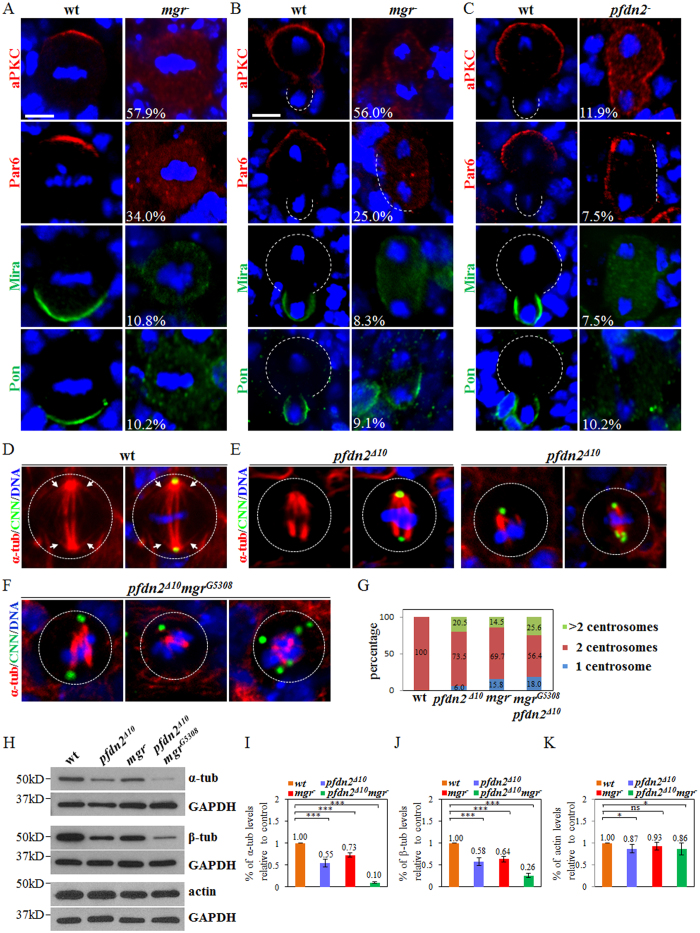
Pfdn2 and Mgr regulate neuroblast asymmetric division and mitotic spindle assembly.(A,B) Larval brains of wild-type and mgr− [mgrG5308/Df(3R)Exel6160] hemizygote larvae were labeled with aPKC, Par6, Mira, Pon and DNA. (C) aPKC, Par6, Mira, Pon and DNA were labeled in wild-type and pfdn2− [pfdn201239/Df(3L)BSC457] hemizygote larvae. (D-F) Wild-type (D), pfdn2Δ10 (E) and pfdn2Δ10
mgrG5308 (F) larval brains were labeled with CNN, α-tubulin and DNA. Astral microtubules are indicated by white arrows and neuroblasts are outlined by white dotted lines. (G) Quantification of centrosome numbers. (H–K) Western blot of α-tubulin, β-tubulin and actin. Protein extracts from wild-type, pfdn2Δ10, mgr− [mgrG5308/Df(3R)Exel6160] hemizygote and pfdn2Δ10
mgrG5308 larval brains were probed by anti-α-tubulin, anti-β-tubulin and anti-actin. GAPDH is loading control. The expression levels of α-tubulin (I), β-tubulin (J) and actin (K) were quantified. ***indicates p < 0.001, *indicates p < 0.05, ns indicates p > 0.05. Error bars indicate mean standard deviation. Scale bars: 5 μm (A,D–F), 4 μm (B–C).